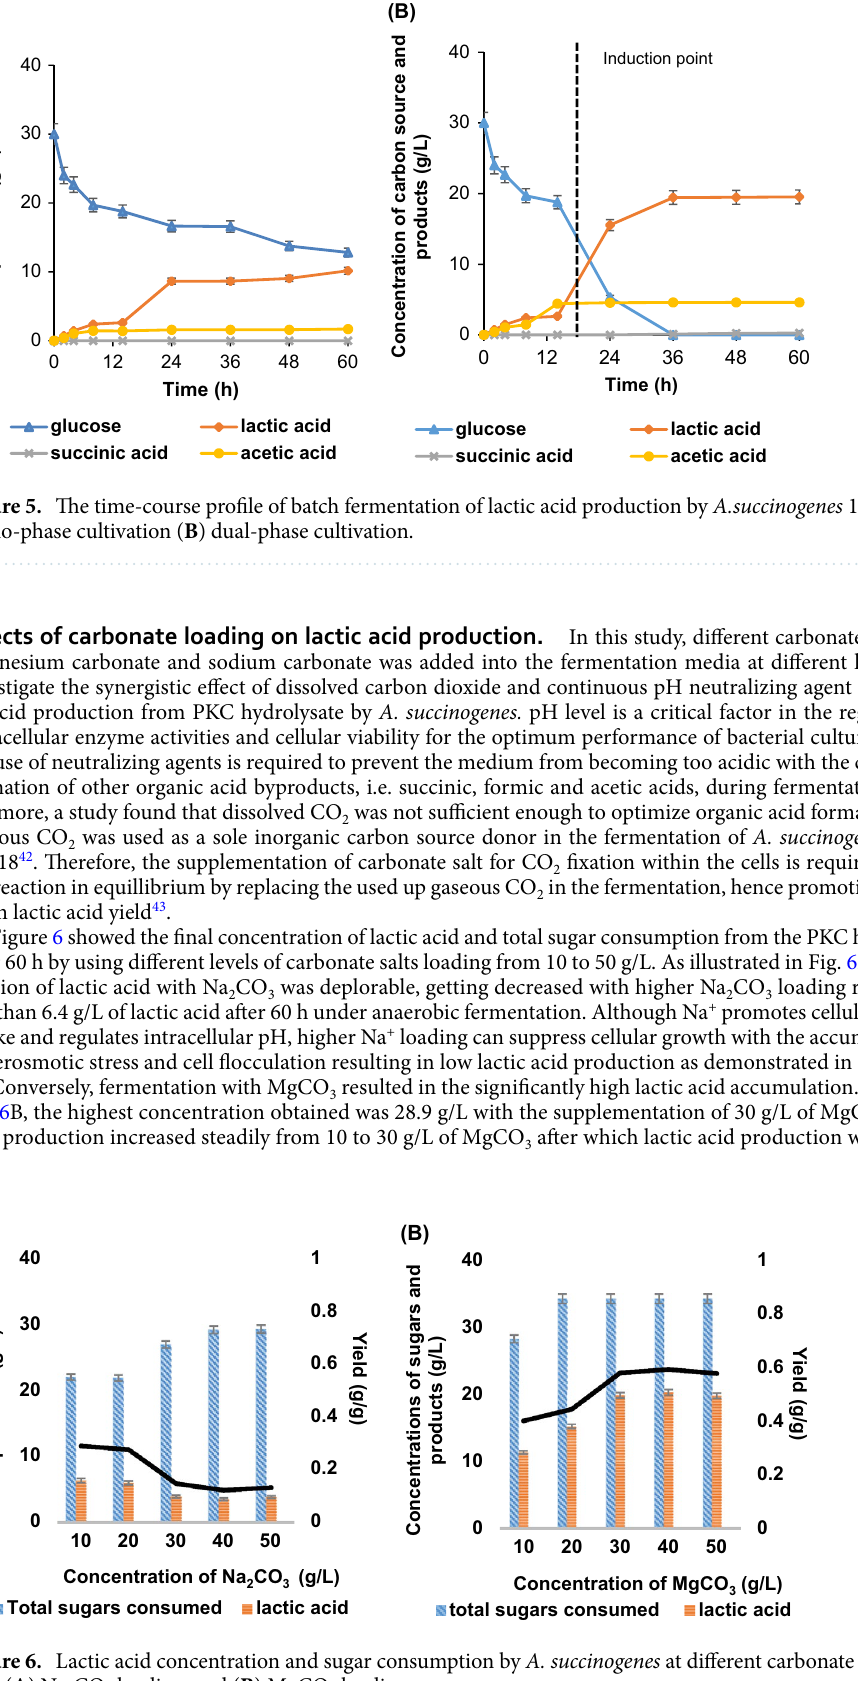
Figure 6. Lactic acid concentration and sugar consumption by A. succinogenes at different carbonate loading with ( A ) Na 2 CO 3 loading, and ( B ) MgCO 3